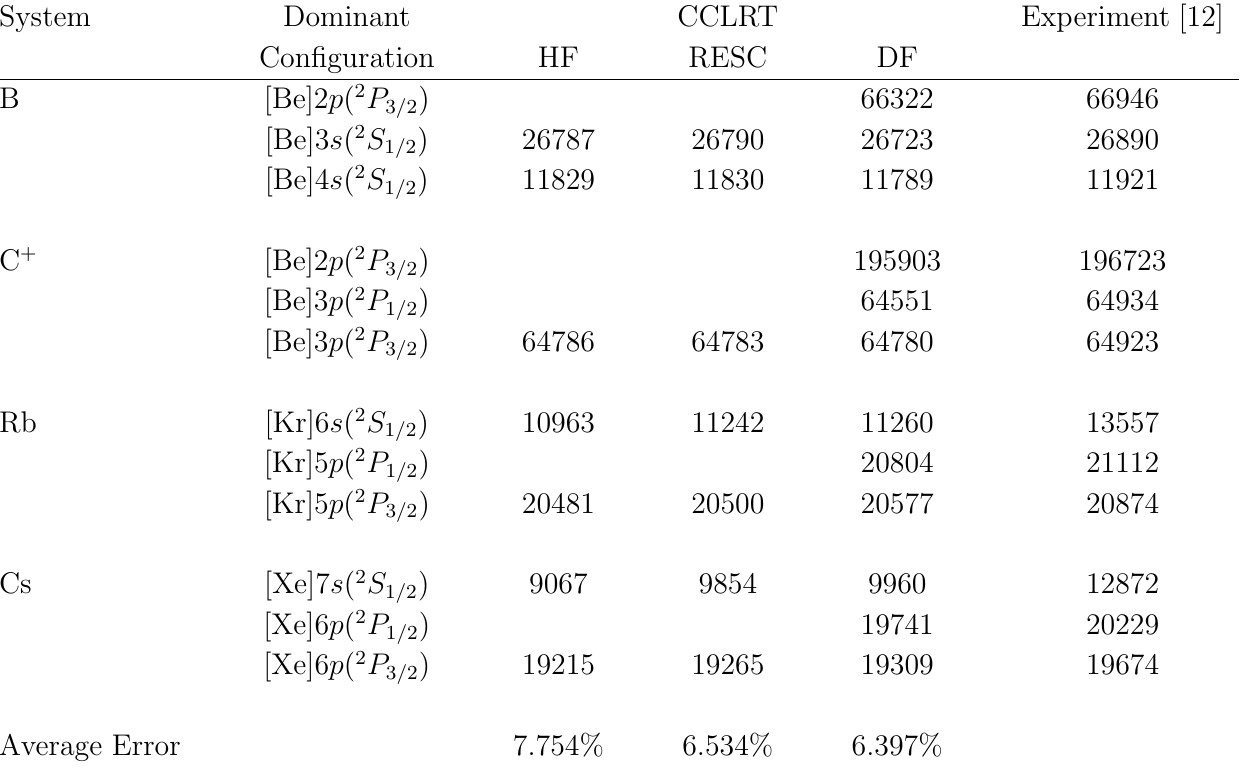
Table 3: Valence electron removal energies (in cm − 1 ) of B, C + , Rb, and Cs obtained from CCLRT- EA method using Hartree-Fock (HF), RESC, and Dirac-Fock (DF)